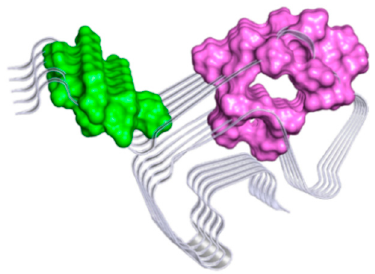
Figure 6. Ensemble consensus sites highlighted as different colored surfaces: site A (colored in magenta) and site B (colored in green). The image was prepared by the Pymol program [25] .